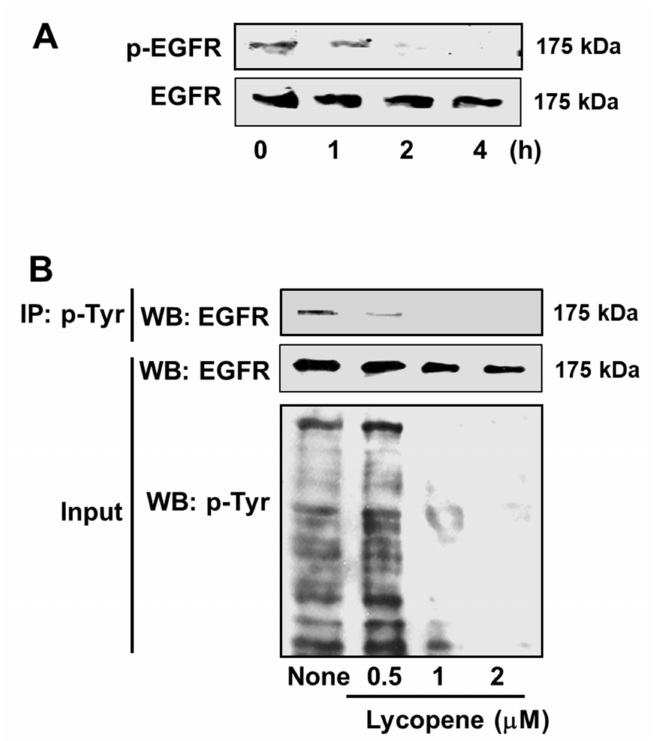
Figure 5. Lycopene inhibits epidermal growth factor receptor (EGFR) transactivation. ( A ) The cells were treated with 2 µ M lycopene for the indicated time periods. The protein levels of p-EGFR and EGFR were examined by Western blot analysis. ( B ) The cells were treated with the indicated concentrations of lycopene for 2 h. Whole-cell extracts were subjected to immunoprecipitation (IP) with anti-phosphorylated tyrosine (p-Tyr) antibody, followed by subsequent Western blot analysis (WB) with anti-EGFR antibody (upper panel). The input of EGFR and p-Tyr was determined by Western blot analysis and served as control for the amounts of EGFR and p-Tyr (lower panel). The cells treated with a vehicle tetrahydrofuran without lycopene were expressed as